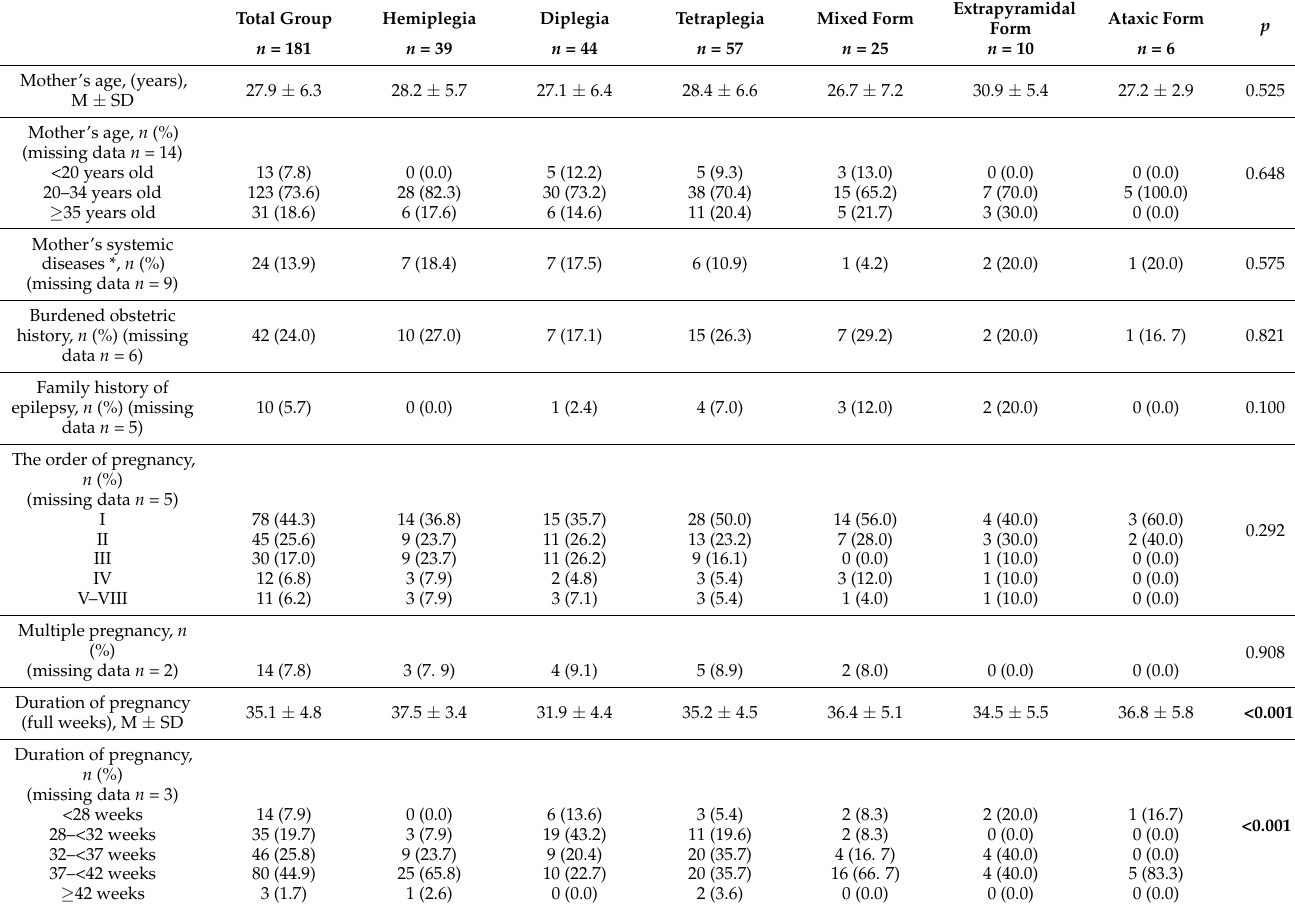
Table 2. Frequency of preconception and prenatal risk factors depending on CP